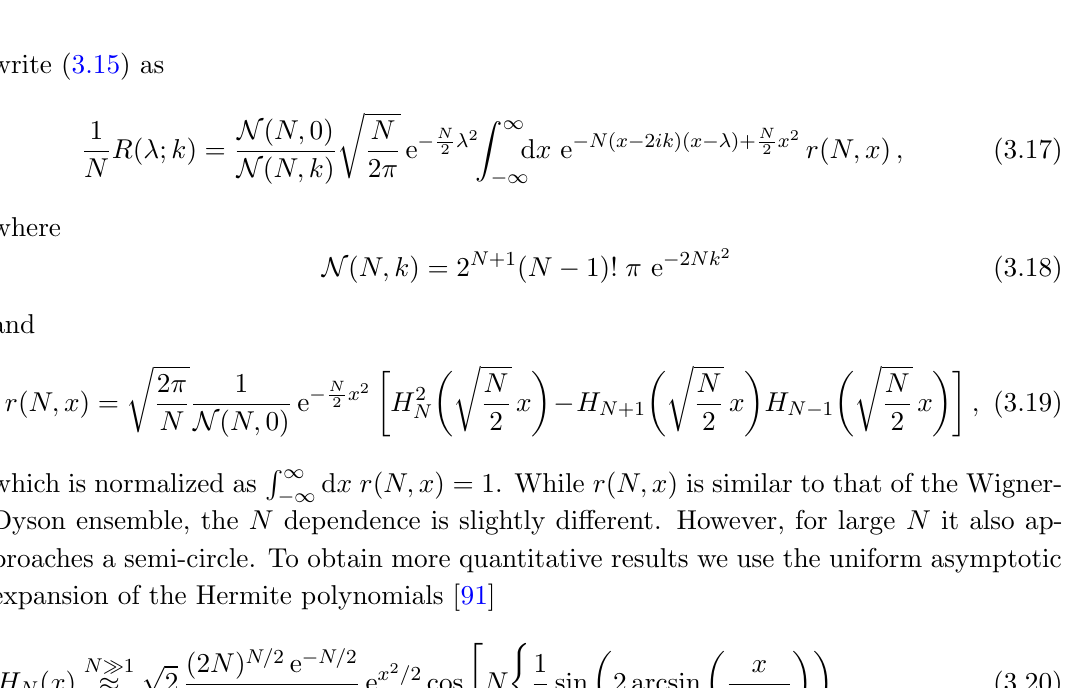
Figure 7 . r ( N; x ) and its large- N approximation (3.21) for N =